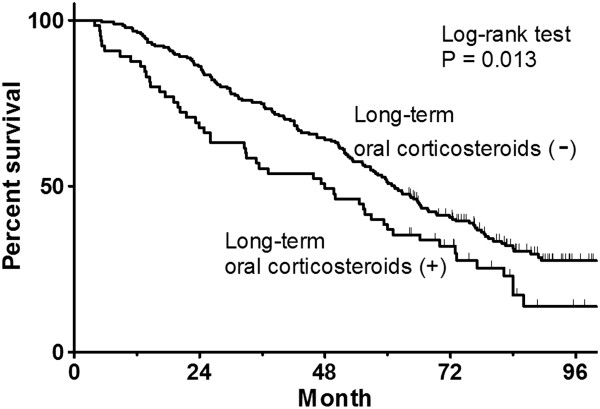
Kaplan-Meier survival curve on the propensity-score-matched cohort (Model 2).